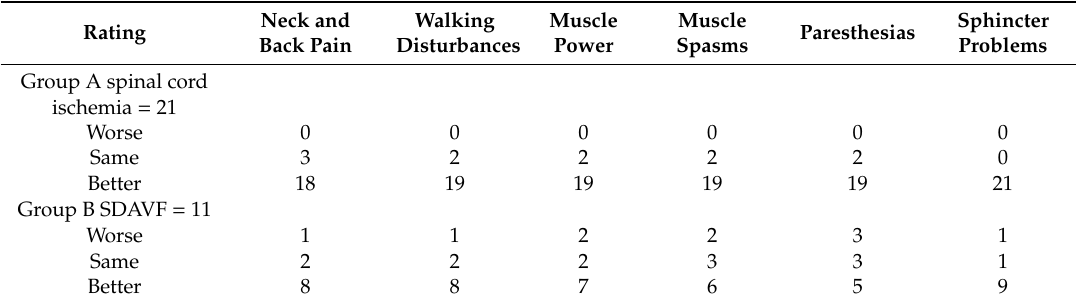
Table 2. The symptoms after three months of onset at patients with spinal cord ischemia and SDAVF.